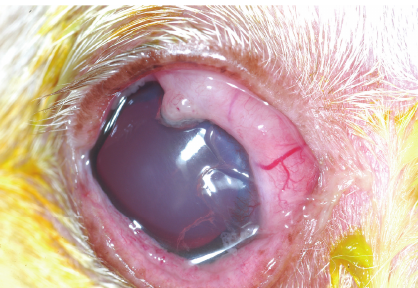
Figure 2: Appearance of right eye 2 weeks after initial presentation. Notice severe periorbital swelling, conjunctival hyperemia, and corneal edema and